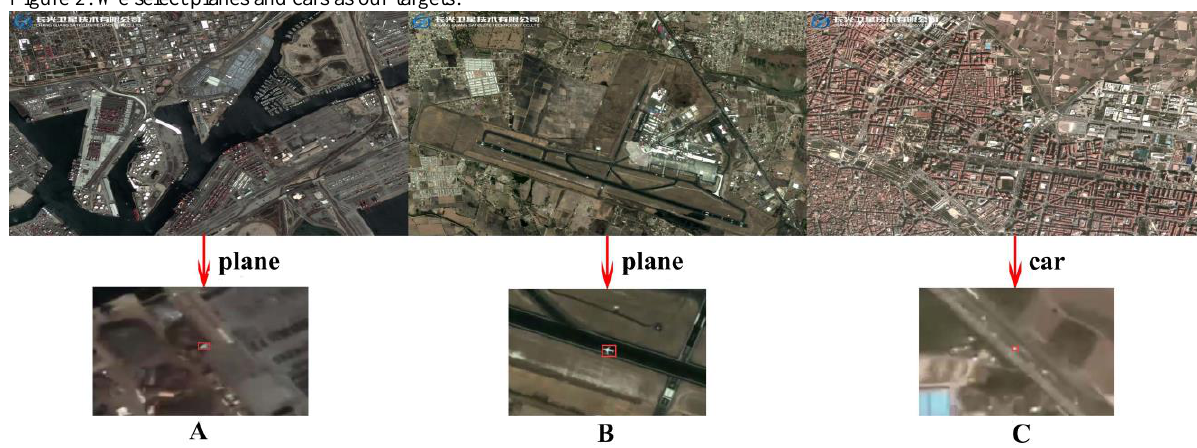
Figure 2. We select planes and cars as our targets.